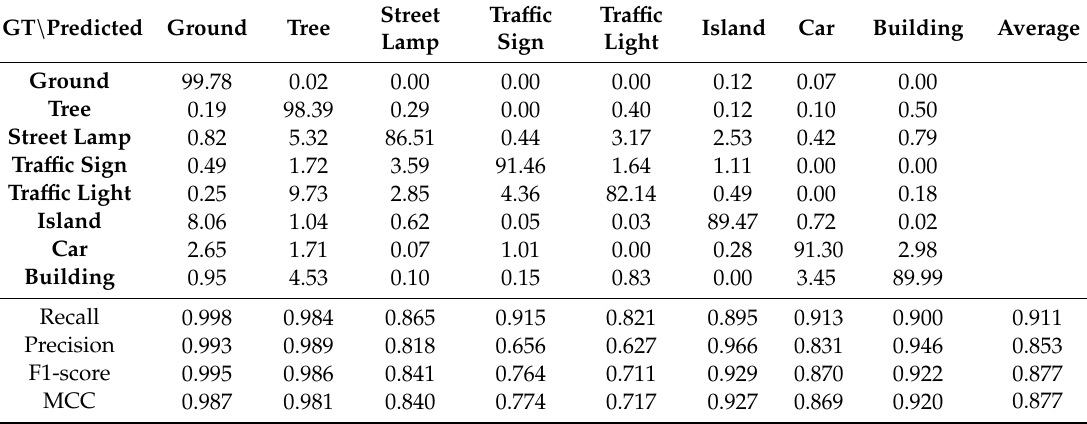
Table 12. Normalized Confusion matrix of